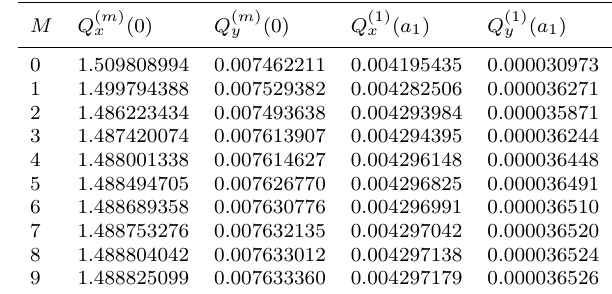
Table 2. The flux components for different numbers of M , while other problem parameters are: θ = 0, λ k = 100 , γ k = 0 . 01, β k = − 0 . 01 and the configuration of the inclusions being defined by